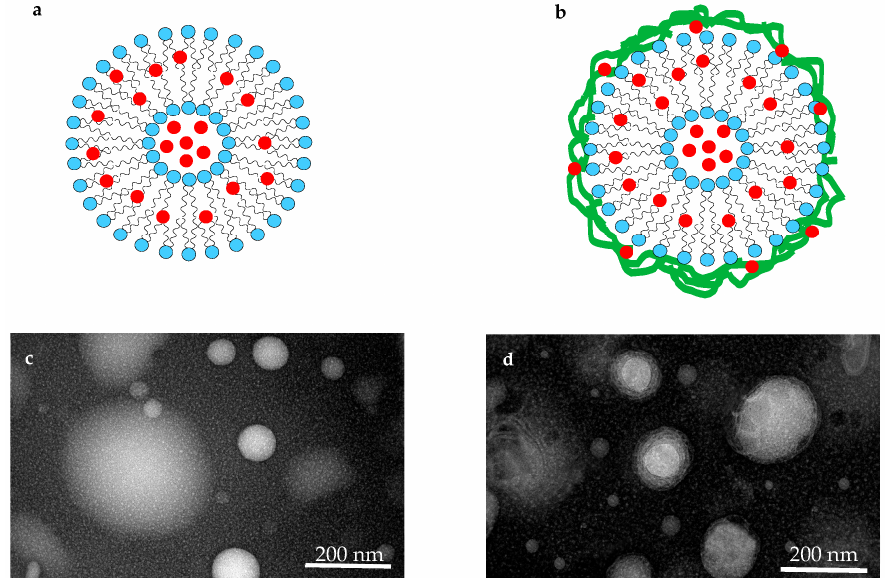
Figure 1. Schematic illustration of nanoliposomes: ( a ) uncoated nanoliposomes; ( b ) coated nanolipo- somes; TEM images of nanoliposomes; ( c ) uncoated nanoliposomes; ( d ) chitosan-coated nanolipo- somes. :Anthocyanin compounds, : Nanoliposome, : Chitosan.